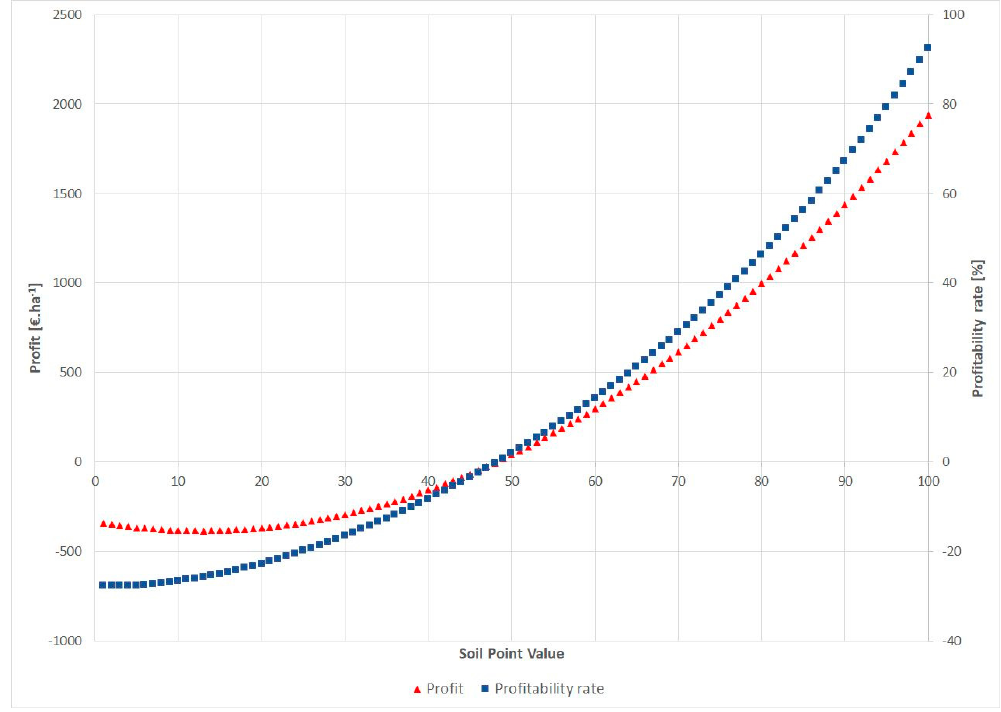
Figure 3. Potential level of profitability and profitability rate of potato cultivation in relation to soil point value.